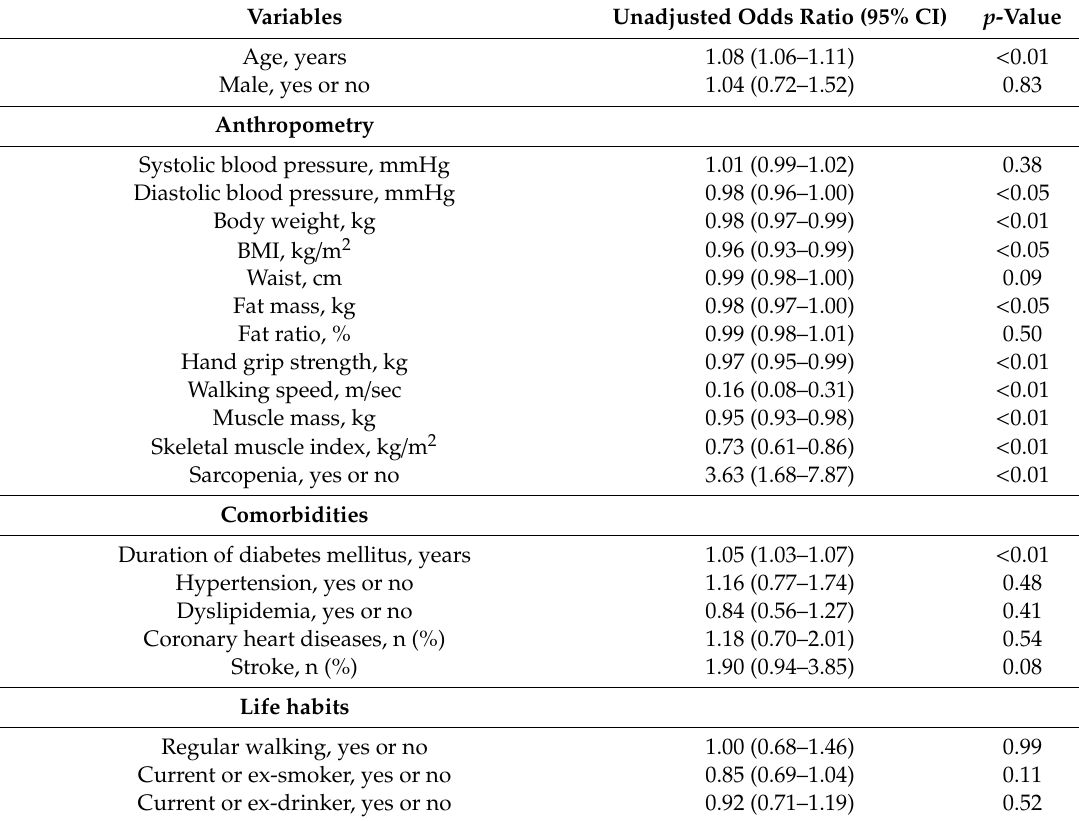
Table 2. Unadjusted odds ration for mild cognitive impairment (MCI) in patients with type 2 diabetes